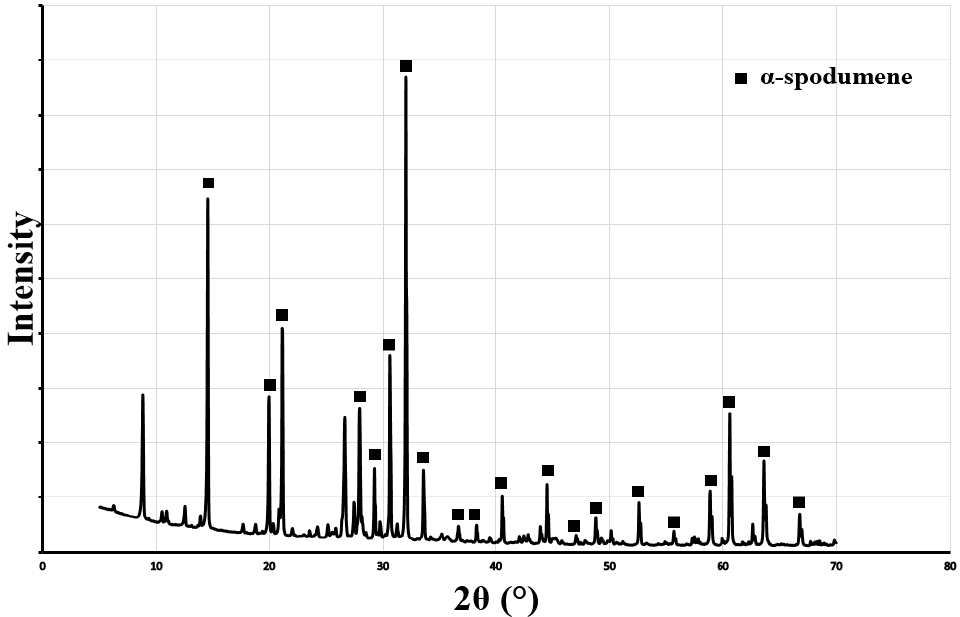
Figure 6. X-Ray pattern of a typical α-spodumene sample, only the main peaks of α-spodumene are indicated .